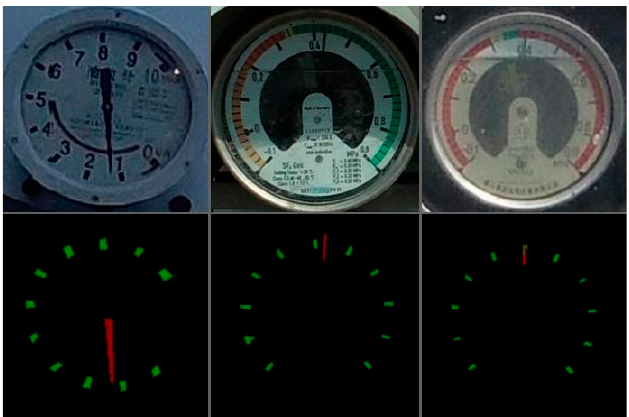
Figure 5. An example of segment datasets.